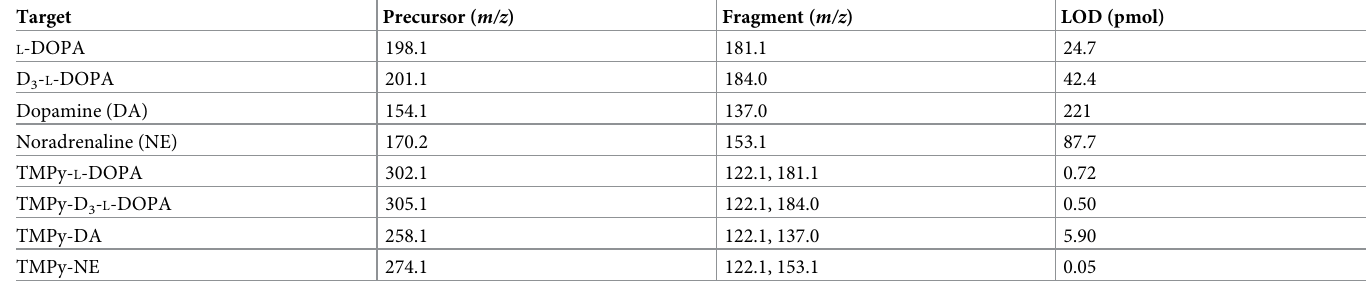
Table 1. Selected monitor ions and detection limit for TMPy-labelled standard catechol amines.